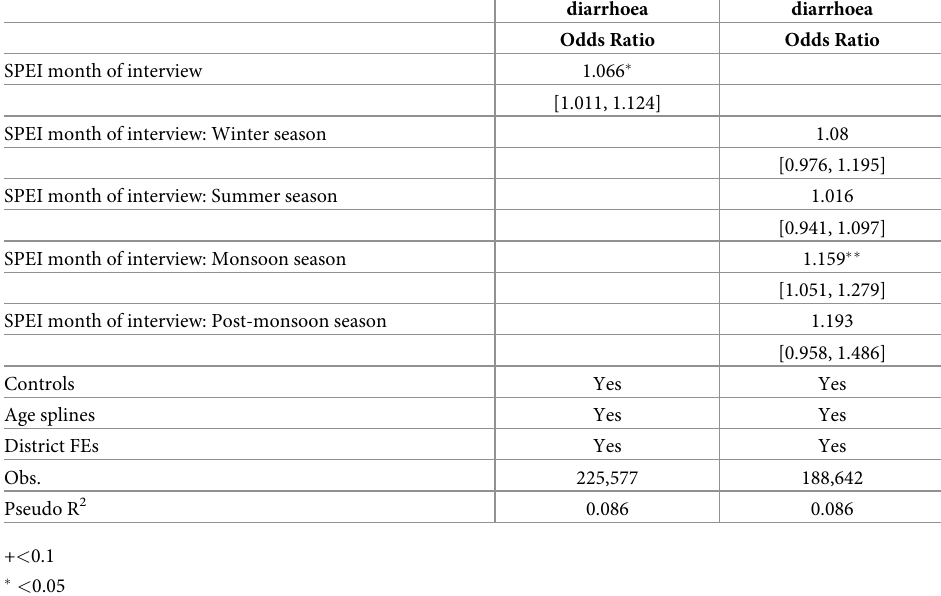
Table 6. Effects of climate in the month of interview on the risk of diarrhoea, children aged